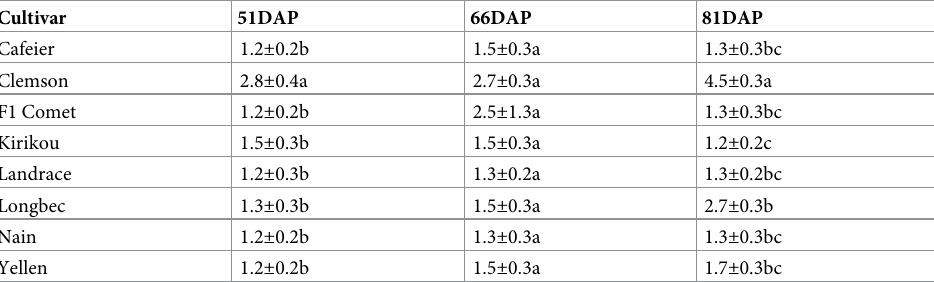
probability level.